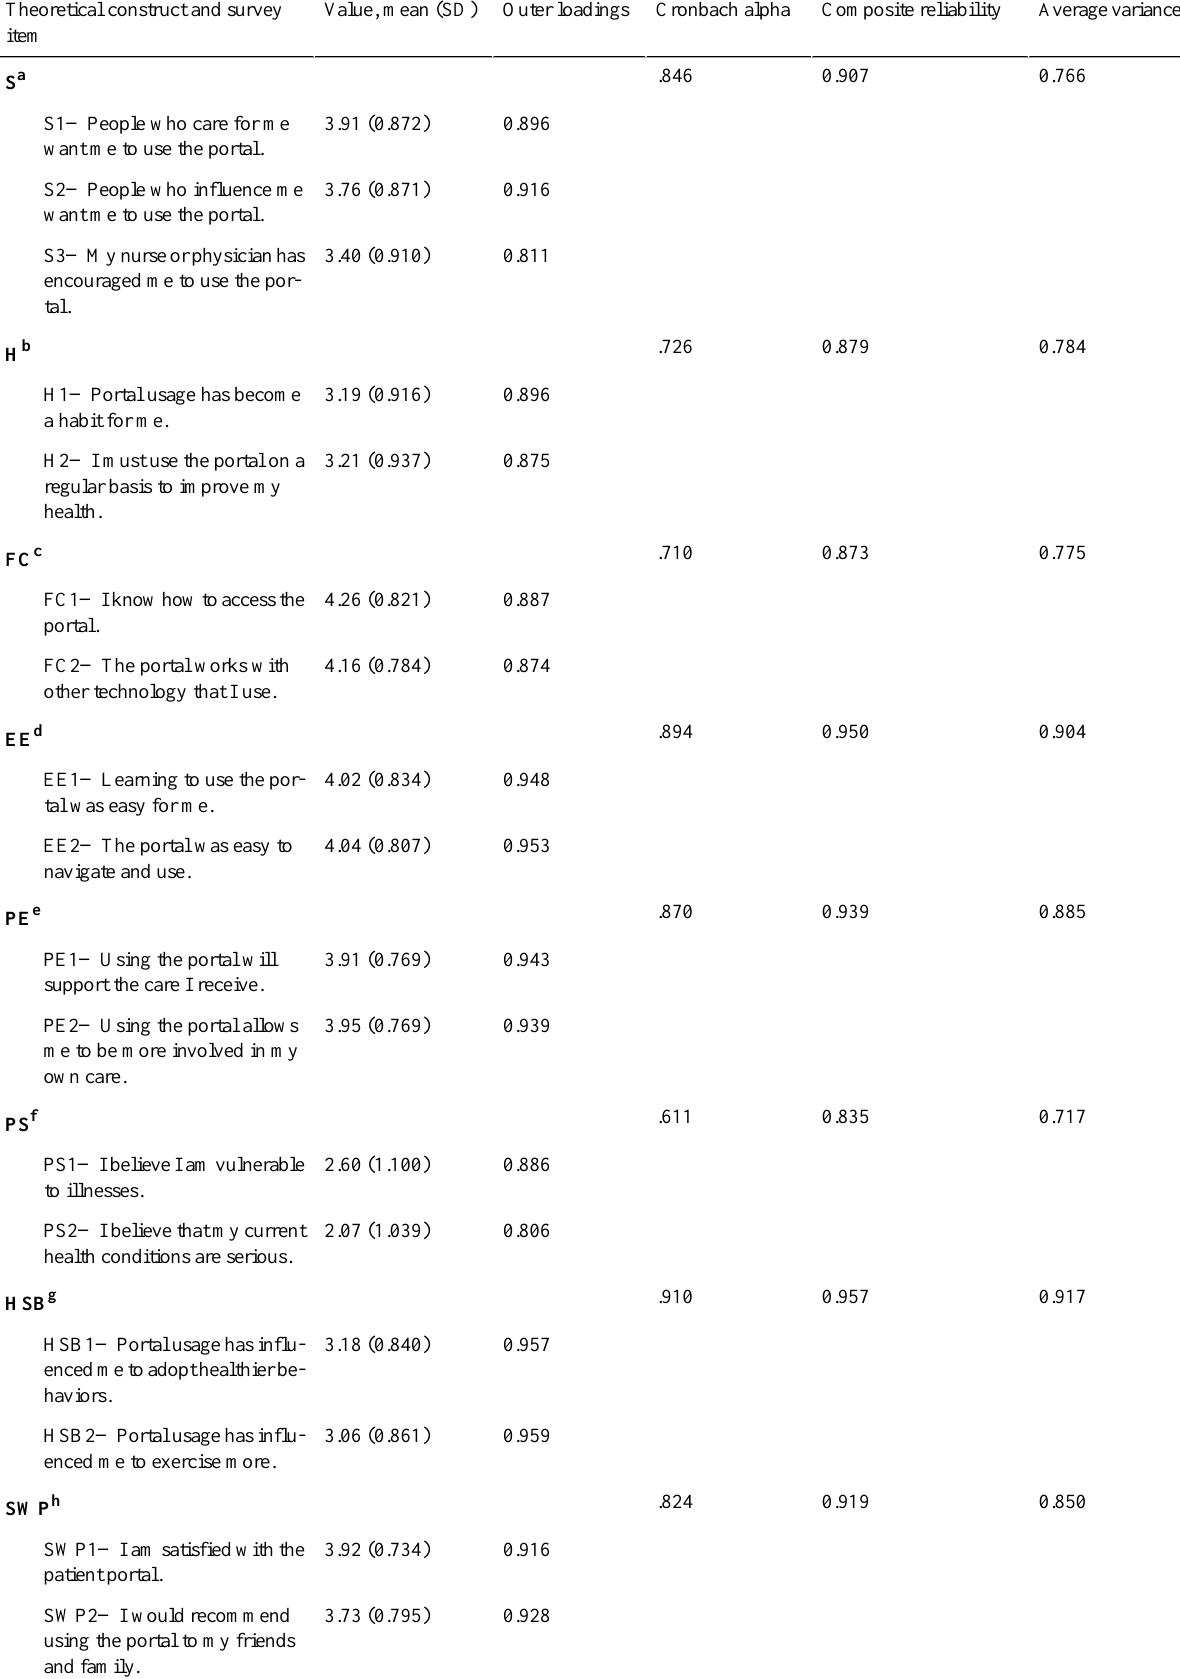
Table 3. Mean response scores and reliability